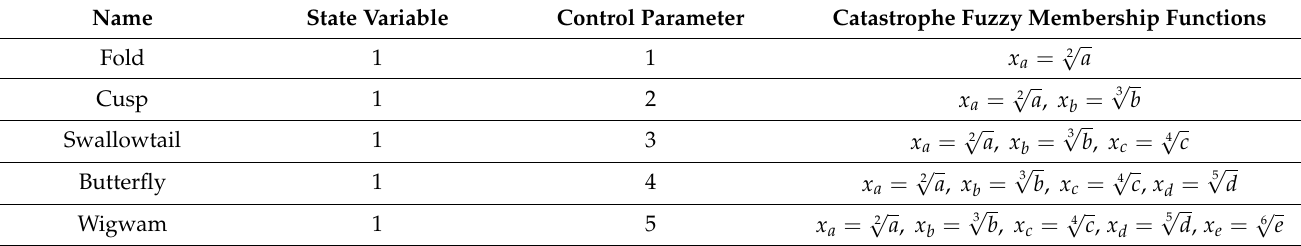
Table 3. Catastrophe functions